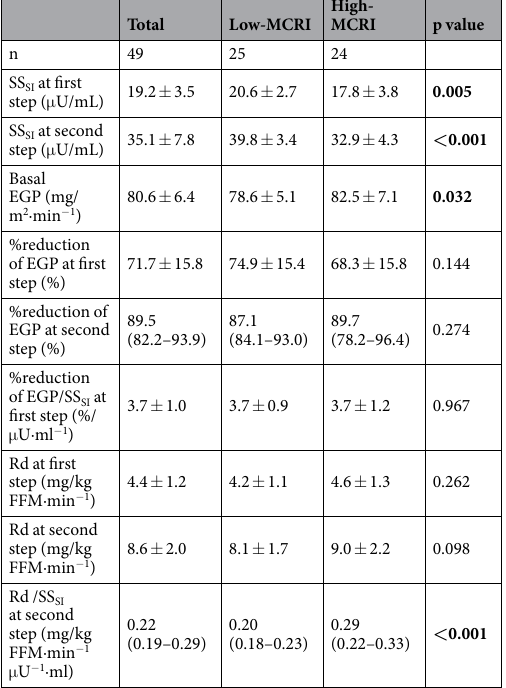
Table 2. Euglycemic hyper-insulinemic clamp data in the Low-MCRI and High-MCRI groups. Data are mean ± SD or median (interquartile range). SS SI ; steady state serum insulin, EGP; endogenous glucose production, Rd; rate of